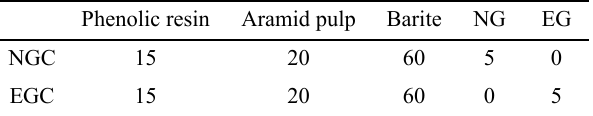
Table 1 Ingredients and mass fraction (wt%) of the friction composites.